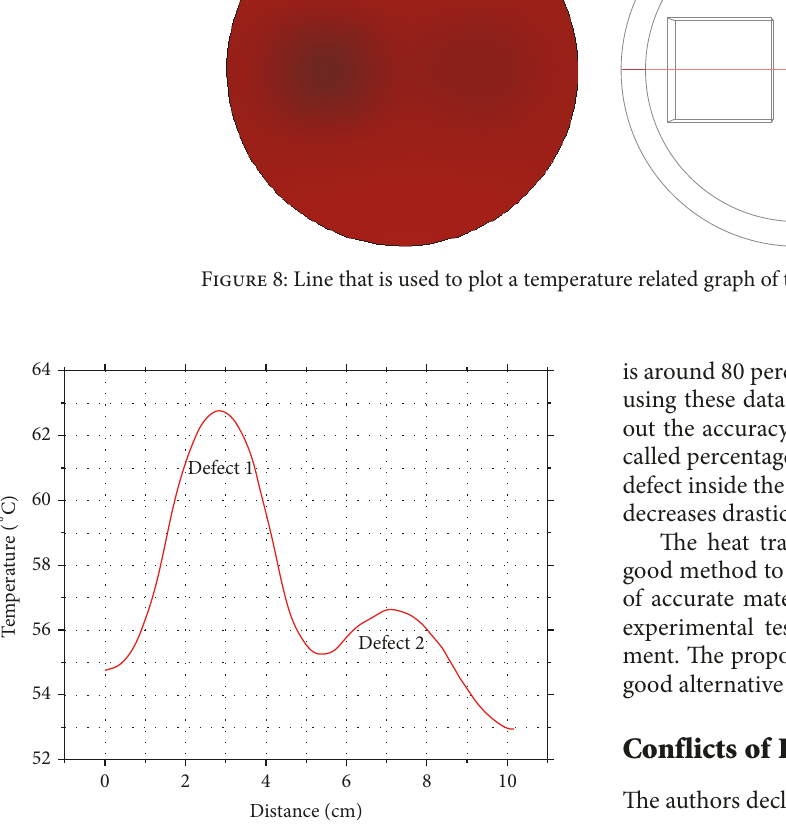
Figure 9: Temperature versus length graph assigned to the line in Figure 8.